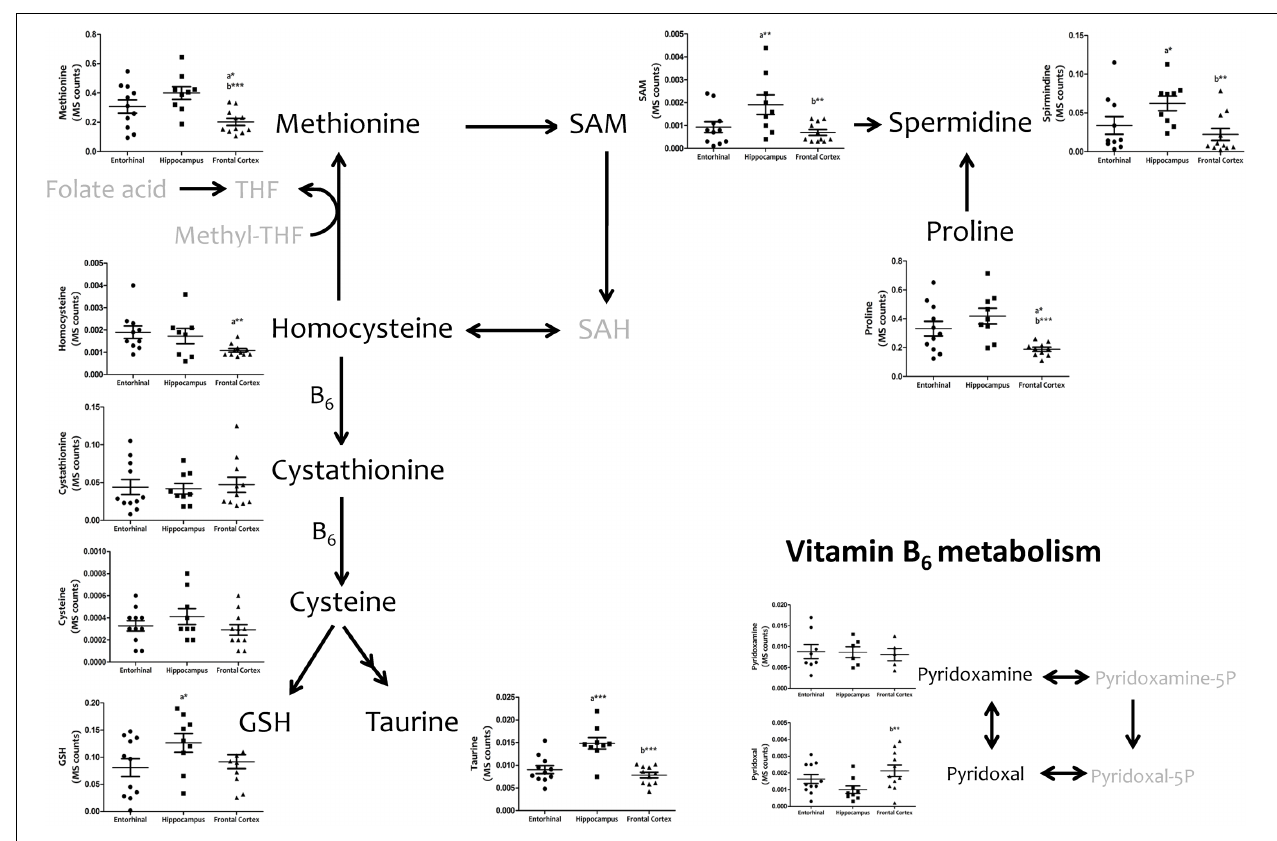
FIGURE 4 | Tissue concentrations of metabolites belonging to the methionine metabolism, including the methionine cycle and the trans -sulfuration pathway, in different regions of the adult human cerebral cortex. All metabolites were measured with TQMS. ∗ p < 0.05; ∗∗ p < 0.01; ∗∗∗ p < 0.001. a, significant differences with respect to entorhinal cortex; b, significant differences with respect to